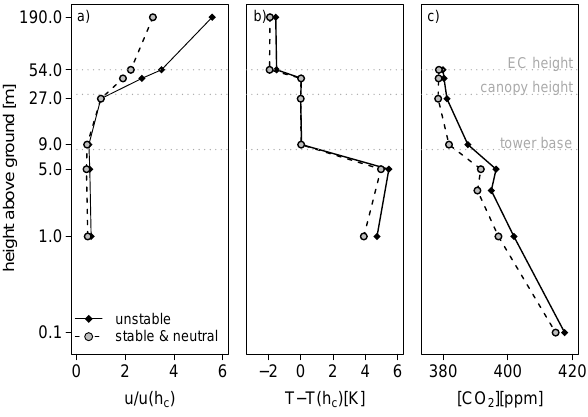
Fig. 5. Vertical profiles for two stability classes (unstable and neu- tral/stable) during May to August 2007 of (a) mean horizontal wind speed normalized by wind speed at canopy height (h c = 30m), (b) mean difference of air temperature and air temperature at canopy height and c) mean CO 2 concentrations. Solid black lines indicate unstable conditions, dotted lines and grey points stable and neutral conditions. The data point at 190m above ground was derived from the MeteoSwiss tower at the L¨ageren ridge.